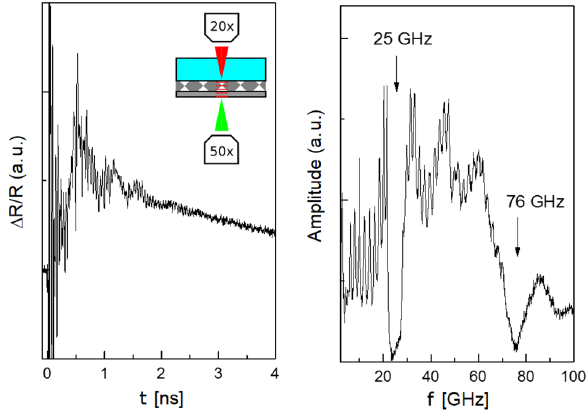
Figure 4. Picosecond ultrasonic data for the Bragg lattice sample after 10 min acquisition, in the time-domain (left) and after Fourier transform (right), where the upper-right inset schema from the time-domain frame illustrates the employed transmittance configuration (pump in red and probe in green, with the former incident on the final titanium layer and the latter on the